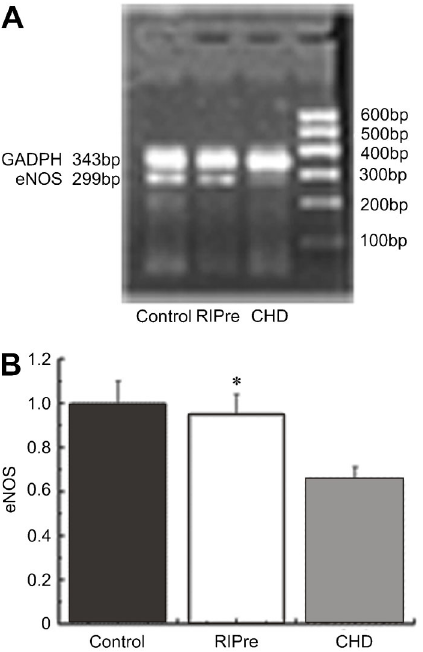
Figure 2. A , Representative Western blot showing phosphory- lated serine-threonine protein kinase (p-Akt), total Akt, and actin in arterial tissues. B , Ratio of p-Akt to Akt. Data are reported as means±SE for n=20 in each group. RIPre: remote ischemic preconditioning; CHD: coronary heart disease. *P , 0.05 vs control group; # P , 0.05 vs CHD (Student-Newman-Keuls test). Note that the immunoblot example does not exactly reflect the mean value of all samples.